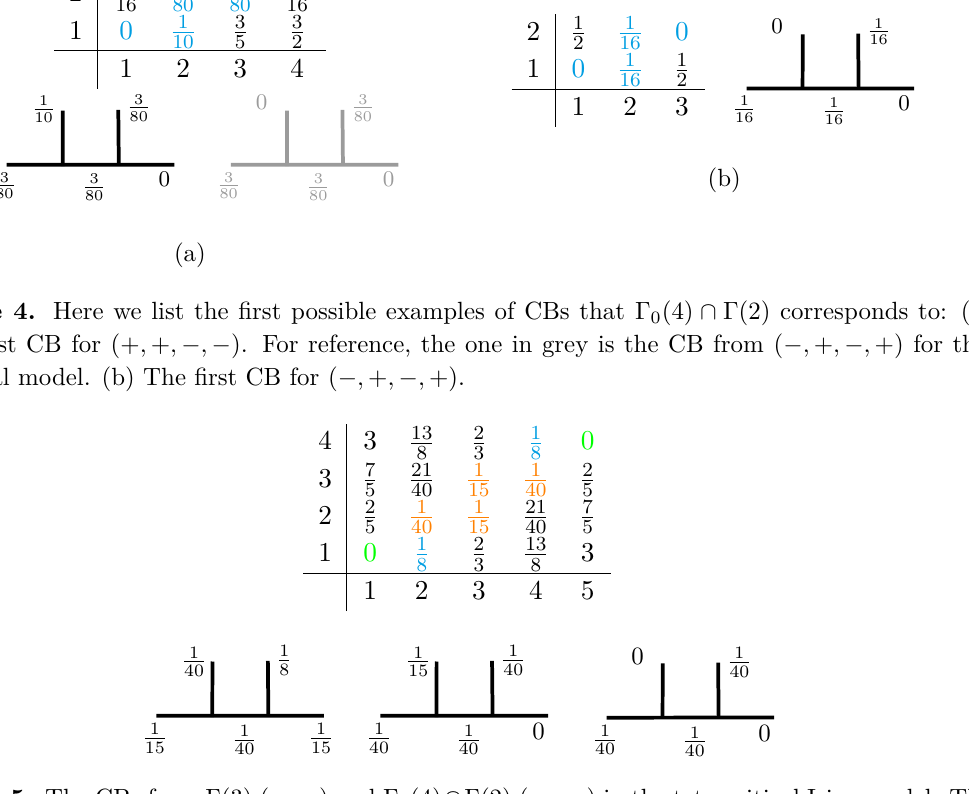
p 0 = 6 , p = 5 as in figure